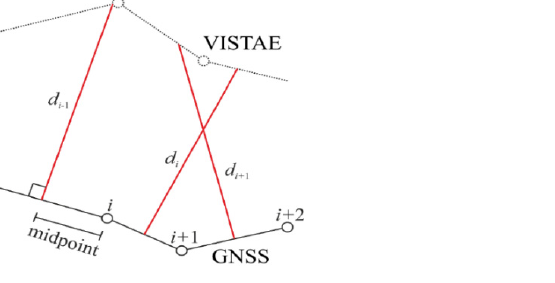
Figure 4. Definition of the distance between GNSS (solid line) and VISTAE (dotted line) shorelines. di (red line) represents the individual distance of each segment joining two adjacent nodes (circles) of the GNSS shoreline to the camera shoreline.